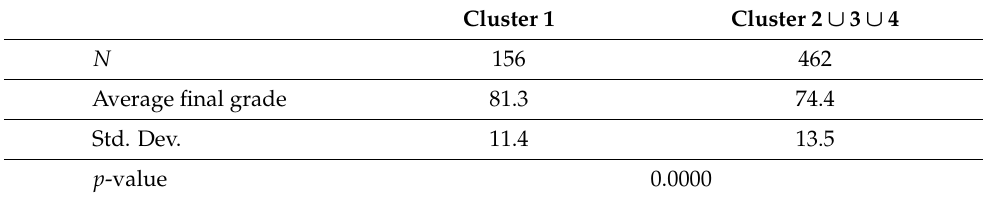
Table 6. p -values for one-tail t -tests comparisons among clusters’ average grades (SRLAS).